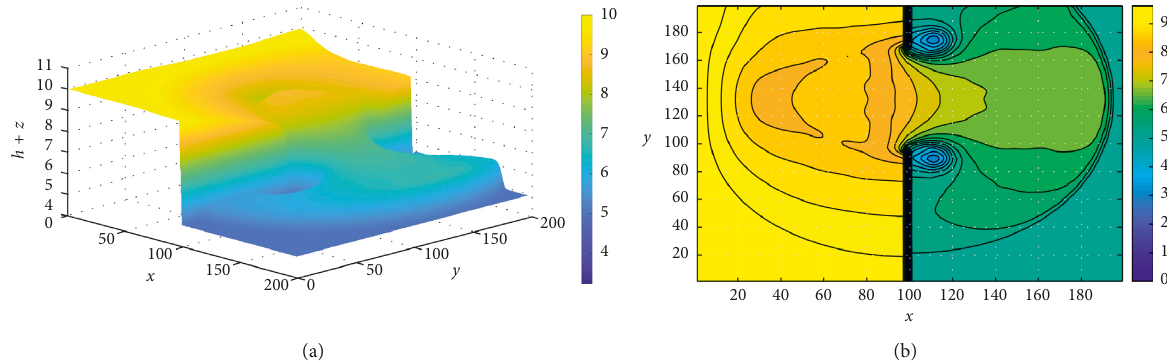
Figure 7: Water level (a) and its contour plot of h (b) of the partial dam-break problem at